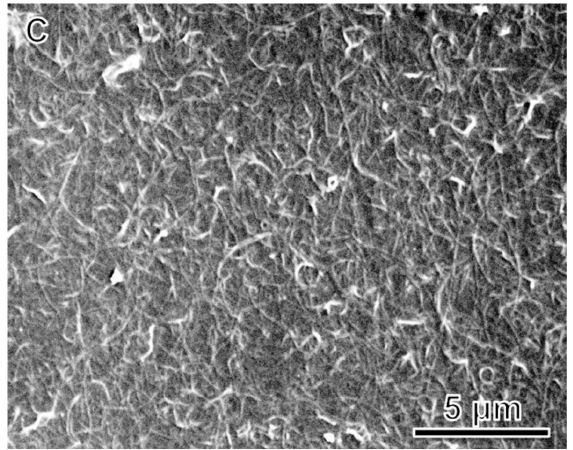
Figure 5. SEM micrographs of rGO-SWNT films prepared from inks with different GO to SWNT mass ratios: ( A ) 5:1, ( B ) 10:1 and ( C ) 20:1.